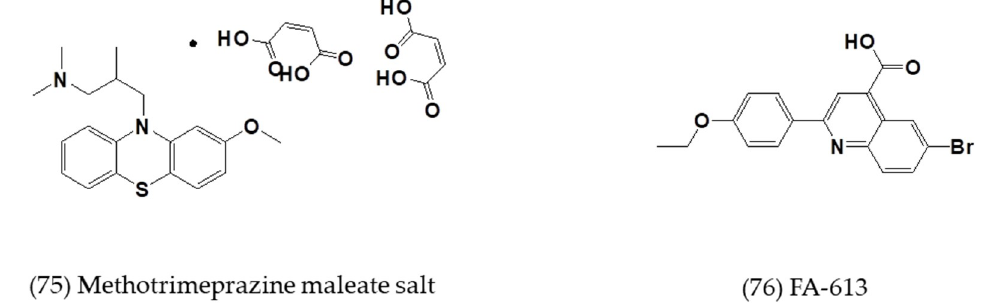
Figure 5. Chemical structure formulae of small-molecule inhibitors of MERS-CoV described in this review.